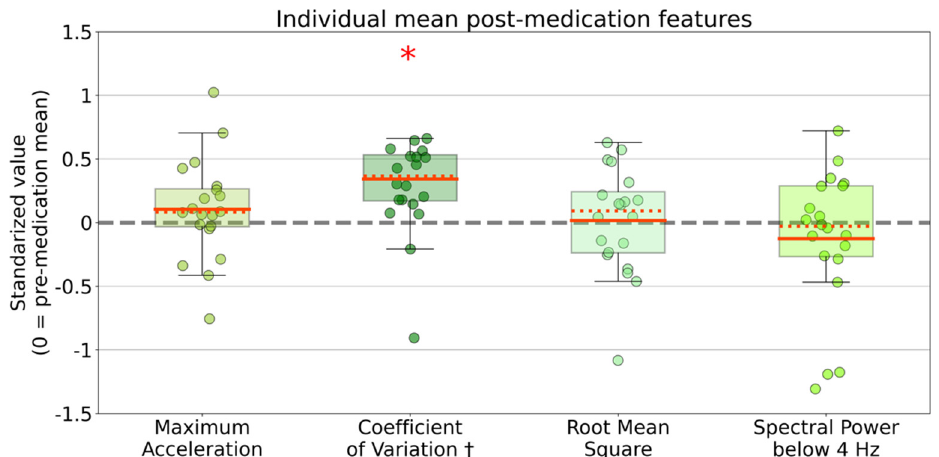
Figure 2. Distributions of individual means for four main movement features. Colored dots represent the mean feature values during the whole post-medication recording per participant ( n = 20). Individual post-medication mean values are standardized as z-scores (individual pre-medication recordings are used as references, and therefore the pre-medication mean values equal 0). The red asterisk indicates a significant difference on group level between mean coefficient of variations of pre- and post-medication means (alpha = 0.05, MANOVA and post-hoc analysis, FDR corrected). † = one positive outlier (1.7) not visualized.